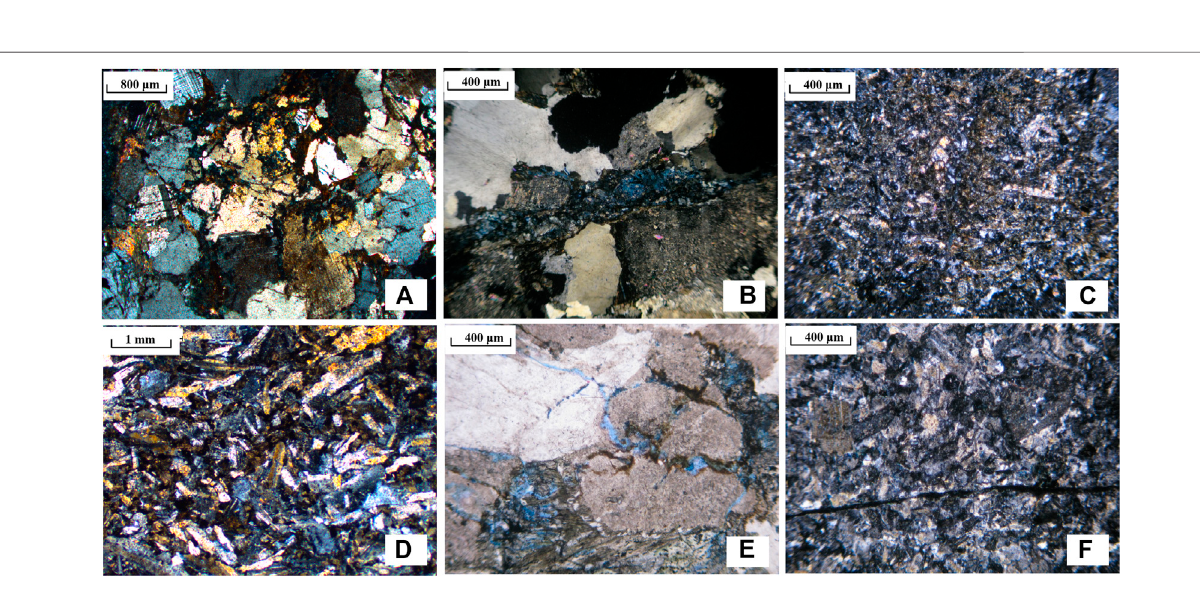
Frontiers in Earth Science |